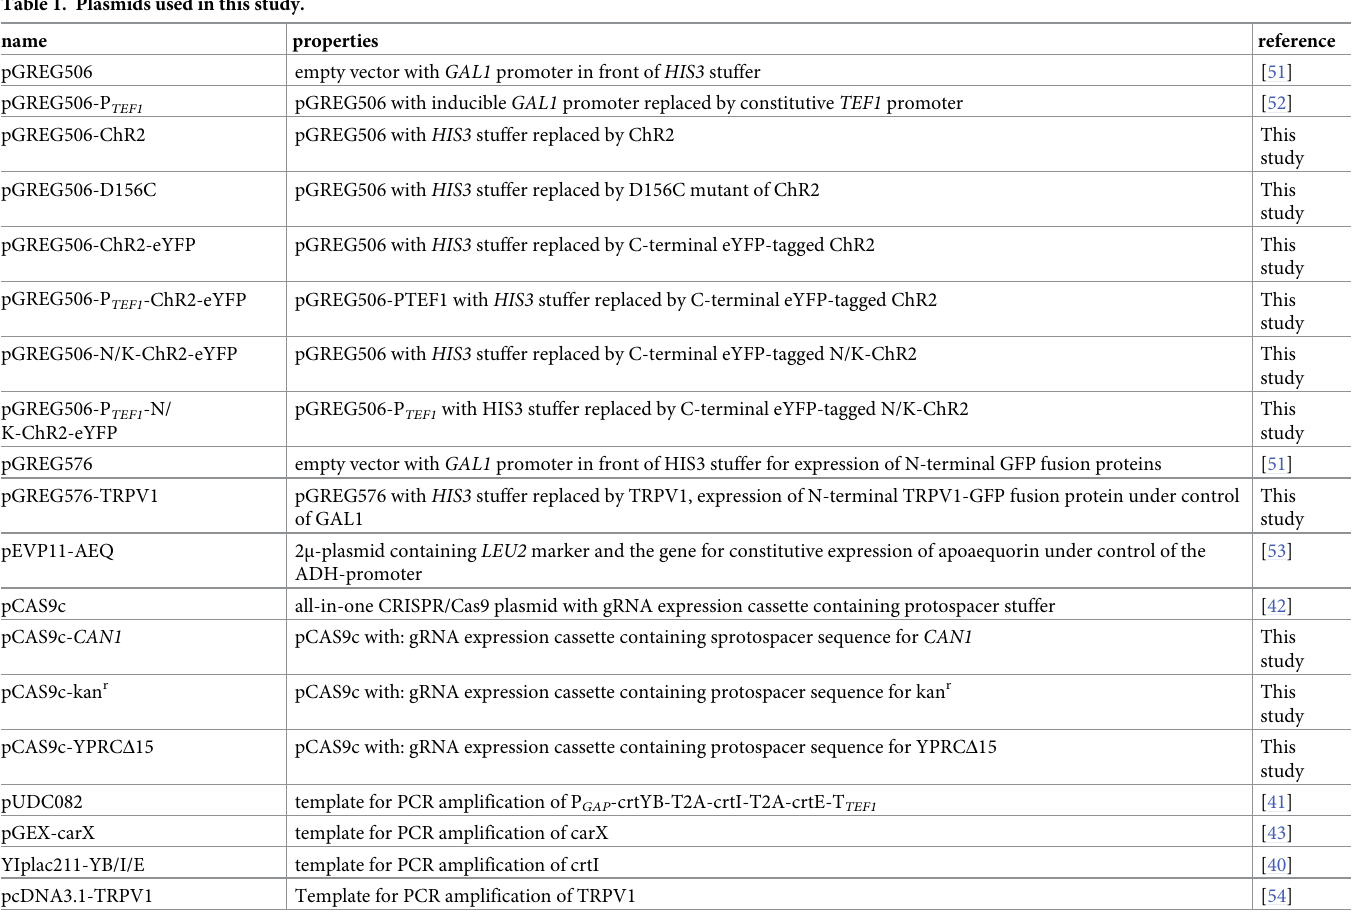
Table 1. Plasmids used in this study.